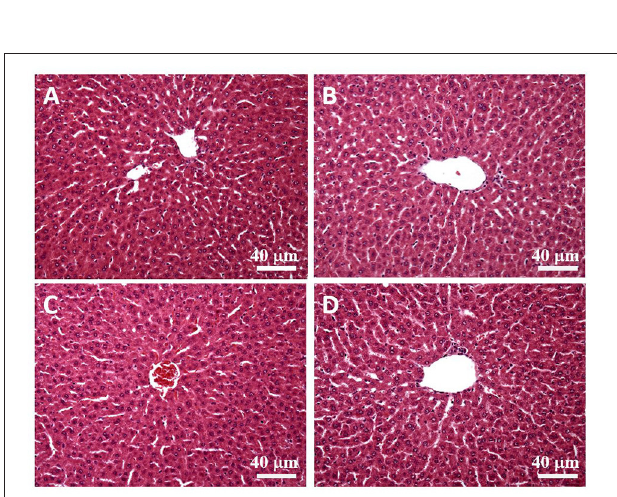
FIGURE 8 | The liver morphology in control (A) and SPSPE treated groups ( B : 1X, C : 2X, D : 5X). The H & E stain was performed and the slices were observed under 200x